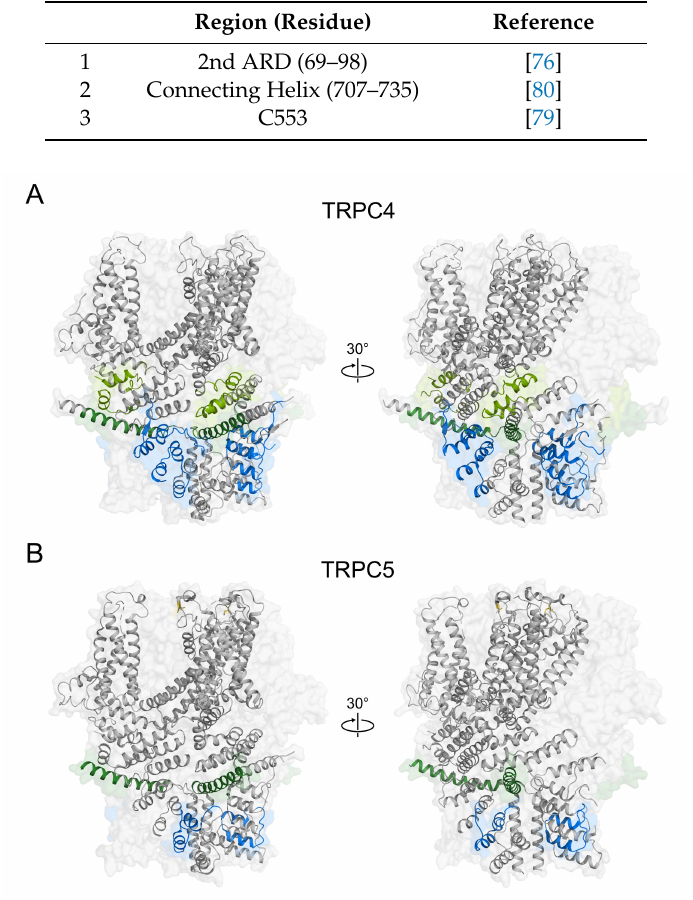
Table 3. Summary of domains responsible for homo- or heterotetramerization of TRPC 5 channels.